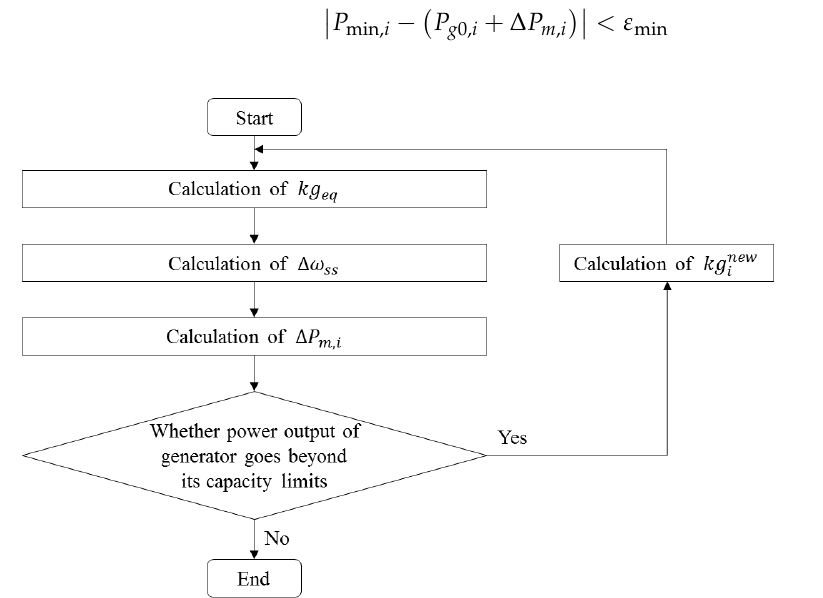
Figure 3. Calculation procedure of kg eq . Only some generators are operated at their maximum or minimum output power